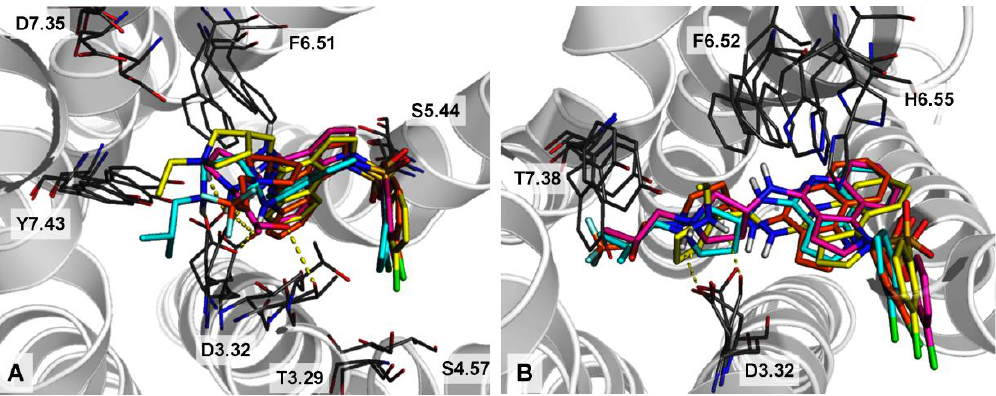
Figure 4. Superposition of the binding modes of 9 (magenta) , 12 (orange), 13 (yellow), and PZ-1643 (cyan) in the 5-HT 6 ( A ) and D 3 R ( B ) binding sites. Complexes were selected as the most populated conformations obtained by the clustering of the MD trajectories.